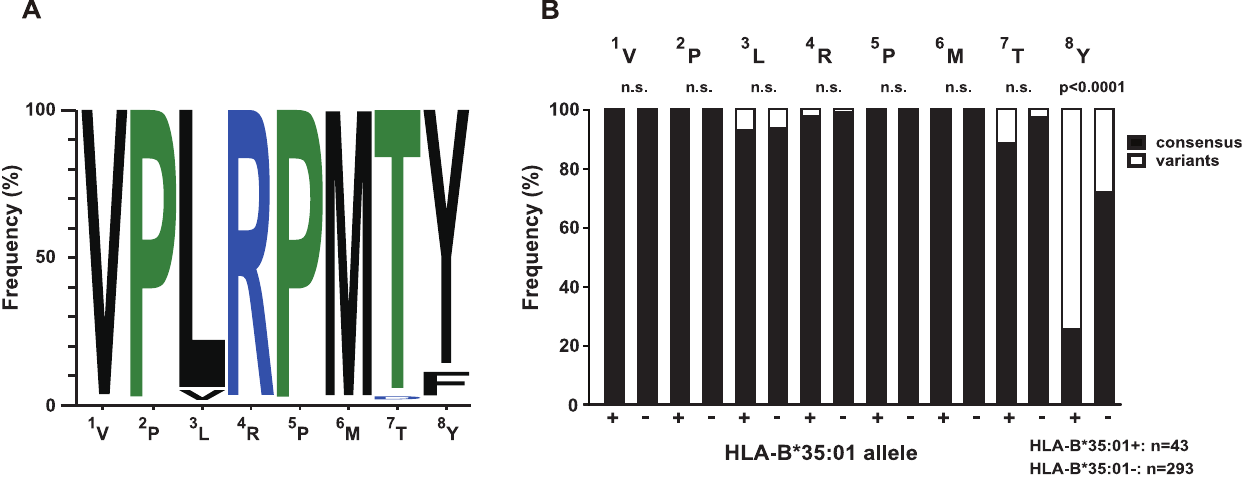
Figure 2. Naturally arising antigenic variations in the VY8 epitope. ( A ) Graphical representation showing the frequency of amino acid residues within the VY8 epitope in subtype B Nef sequences retrieved from the Los Alamos database (n=1191). WebLogo 3 was used to generate the graphic. ( B ) The frequency of consensus (subtype B) and variant amino acid residues at each position of the VY8 epitope is shown for autologous plasma viral sequences derived from a total of 336 HIV-1-infected individuals, segregated according to HLA-B * 35:01 status. Statistical analysis was performed using Fisher’s exact test. n.s ., not significant.